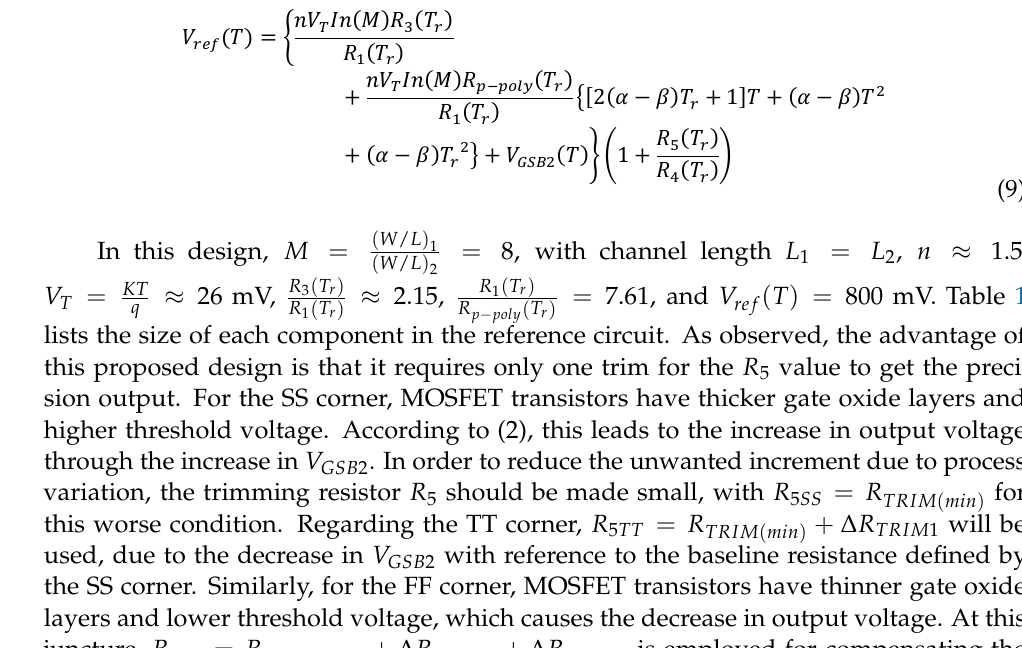
Table 1. Sizes of the Components in Voltage Reference Circuit. Component Size